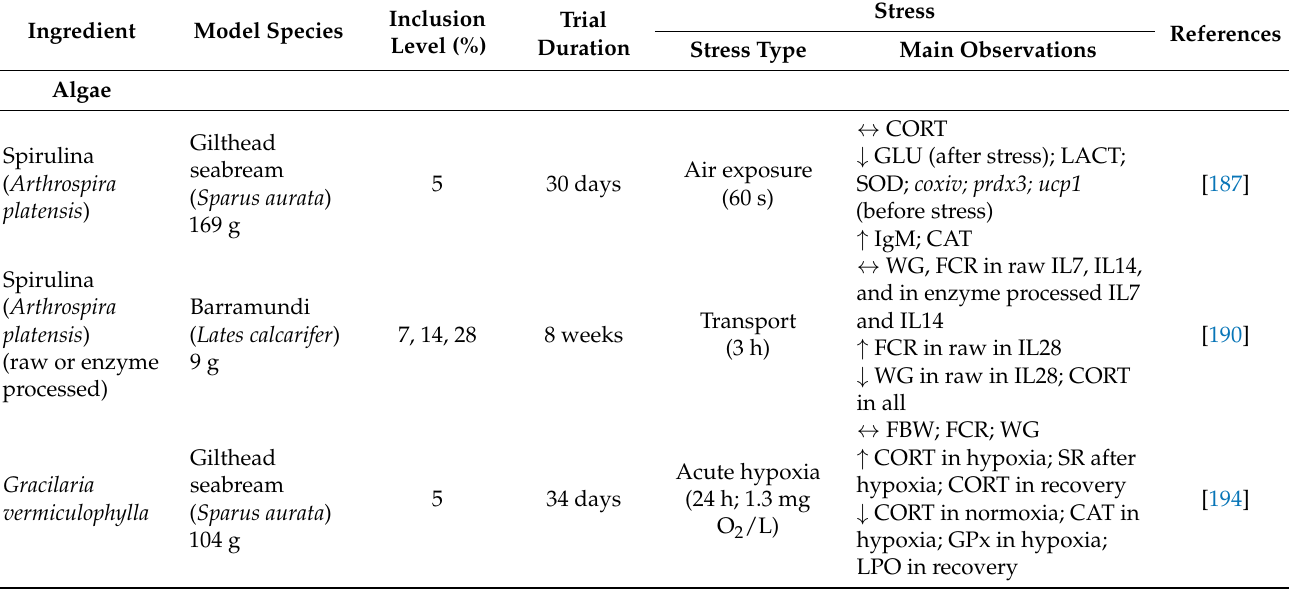
Table 3. Summary of ingredients and their impacts on the growth performance and stress biomarkers of